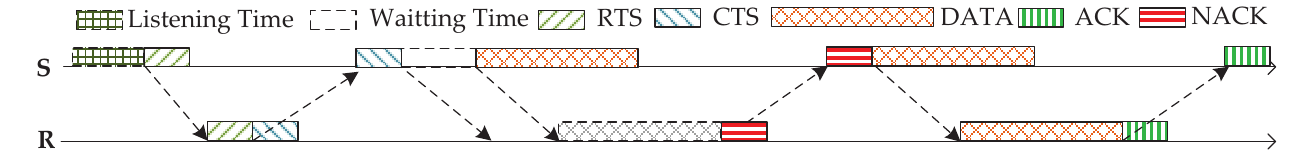
Figure 4. Timing diagram of SFLC-MAC